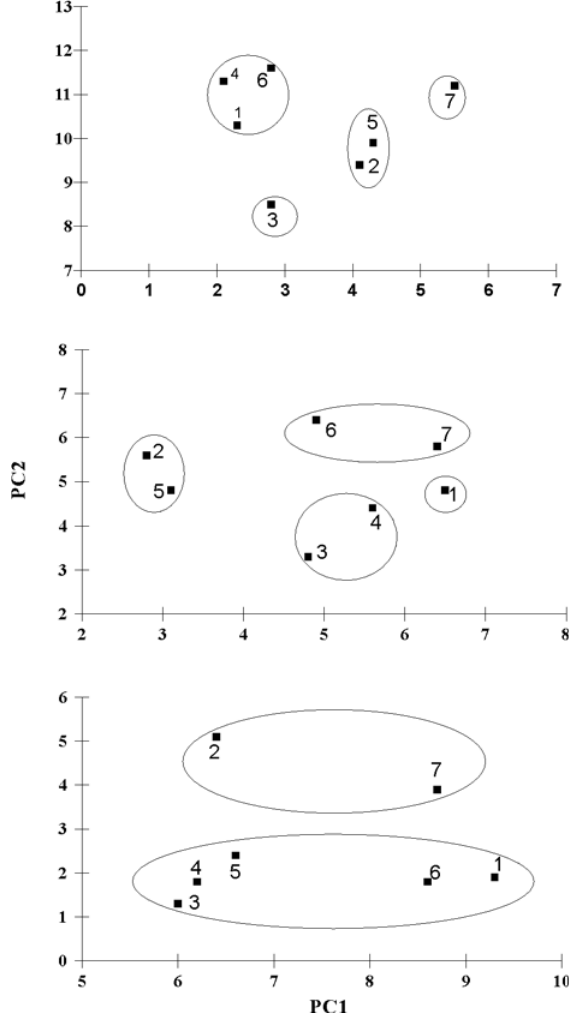
Figure 1. Score dispersion of pure and mixed stands of native forest species based on: (a) height, diameter and tree trunk volume; (b) biomass of leaves, branches, bark and stemwood, and (c) nutrient content (N, P, K, Ca, Mg) in the above- ground biomass as related to principal components (PC1 and PC2) and to grouping by Tocher’s Method, based on the standardized Euclidian average distance. 1: P. angustiflora , 2: C. robustum , 3: A. psilophylla , 4: S. chrysophyllum , 5: C. trichotoma , 6: M. latifolium and 7: mixed-